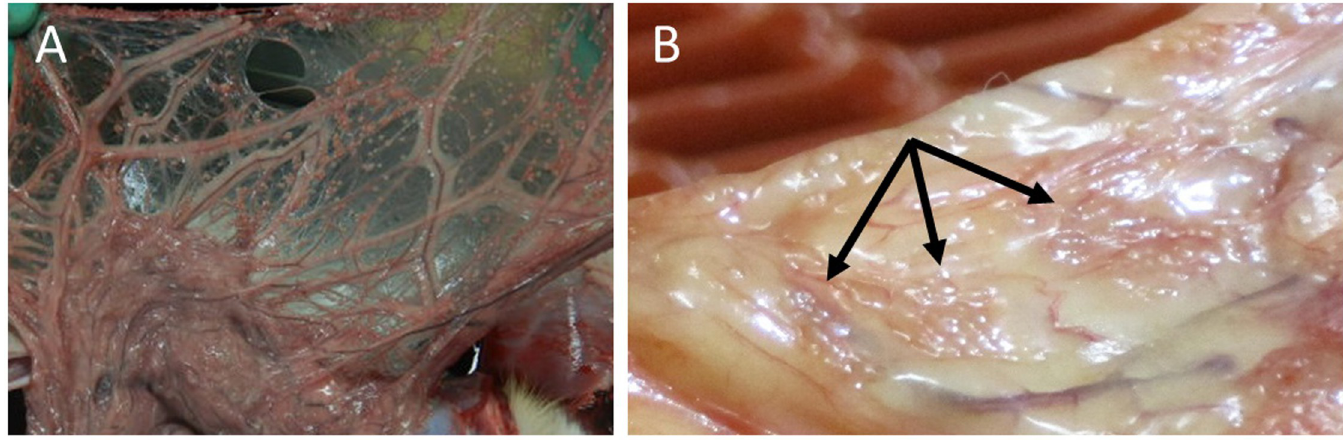
Fig 5. Necropsy images of microspheres attached to the omentum. A) The retrieved omentum is shown from dog #7 with microspheres scattered throughout the tissue. B) A higher magnification of the tissue from another animal illustrates the location of the microspheres (black arrows) and the surrounding blood supply with healthy